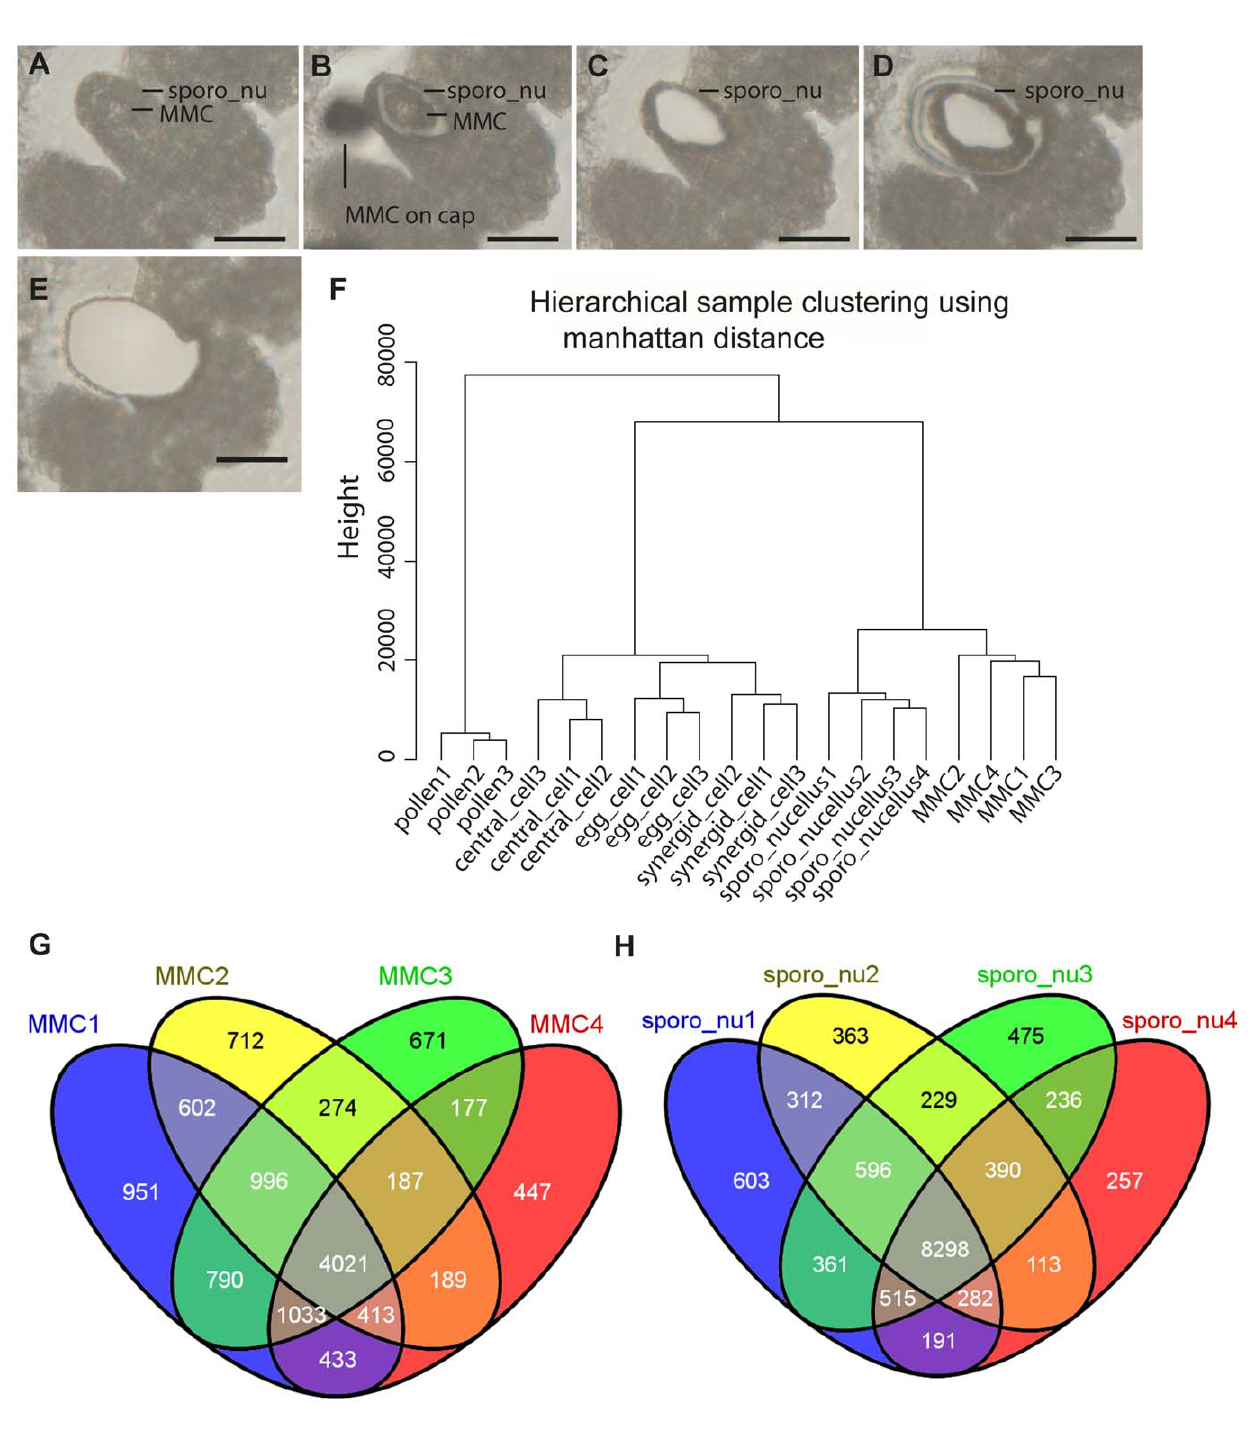
Figure 1. Laser-assisted microdissection (LAM) and transcriptome analysis to study megasporogenesis. (A–E) LAM of the megaspore mother cell (MMC) and the surrounding sporophytic nucellus tissue from a 6 m m dry section (scale bars 20 m m). (A) An ovule harboring the MMC before LAM. (B) The MMC was dissected from the surrounding tissue by applying the ultraviolet laser beam (diameter of , 1 m m). Next to the nucellus is the shade of an MMC previously dissected on the surface of the isolation cap. (C) The ovule from which the MMC has been removed using an MMI isolation cap. (D–E) The surrounding sporophytic nucellus (sporo_nu) was dissected from the remaining ovule tissue (D) and removed with a separate MMI isolation cap (E). (F) Hierarchical sample clustering (manhattan distance) of female gametophytic cell types and pollen (pollen_Schmid as included in the tissue atlas [22]). Biological replicates cluster together, showing high reproducibility of the data. Samples from MMC (megaspore_mothercell) and the surrounding nucellus tissue (sporo_nucellus, sporo_nu) form a close cluster when compared to the mature female and male gametophyte, indicating their close relationship in terms of cell lineage. (G–H) Venn diagrams showing the overlaps of predictions of gene expression (present calls) as determined with the At PANP algorithm.